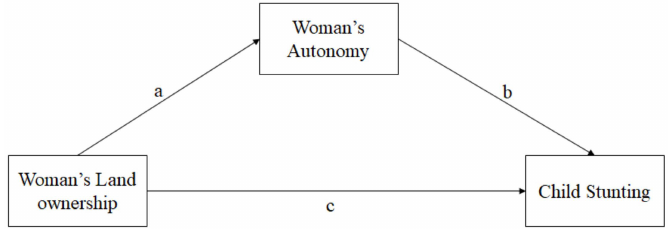
Figure 1. Path diagram of the mediation e ff ect of women’s land ownership on child stunting through women’s